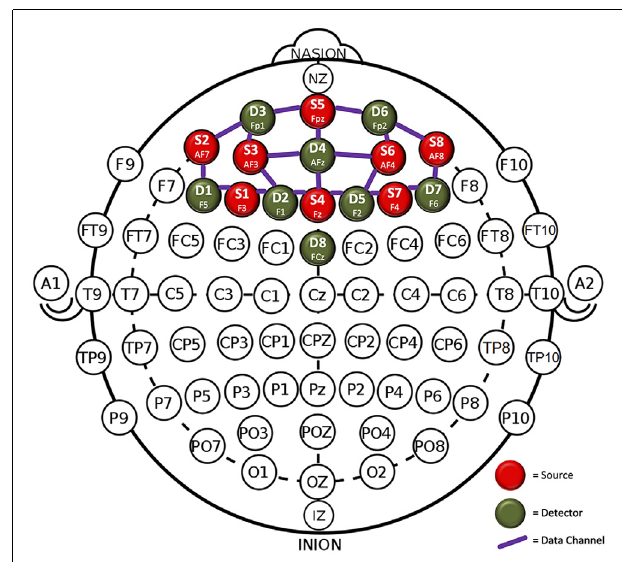
FIGURE 2 | Optode placement in the prefrontal